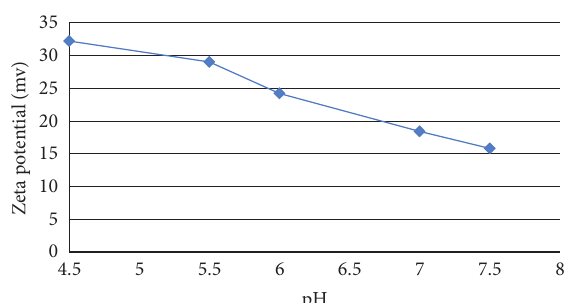
F 1: Variations of the zeta potential with respect to pH for dragon fruit foliage